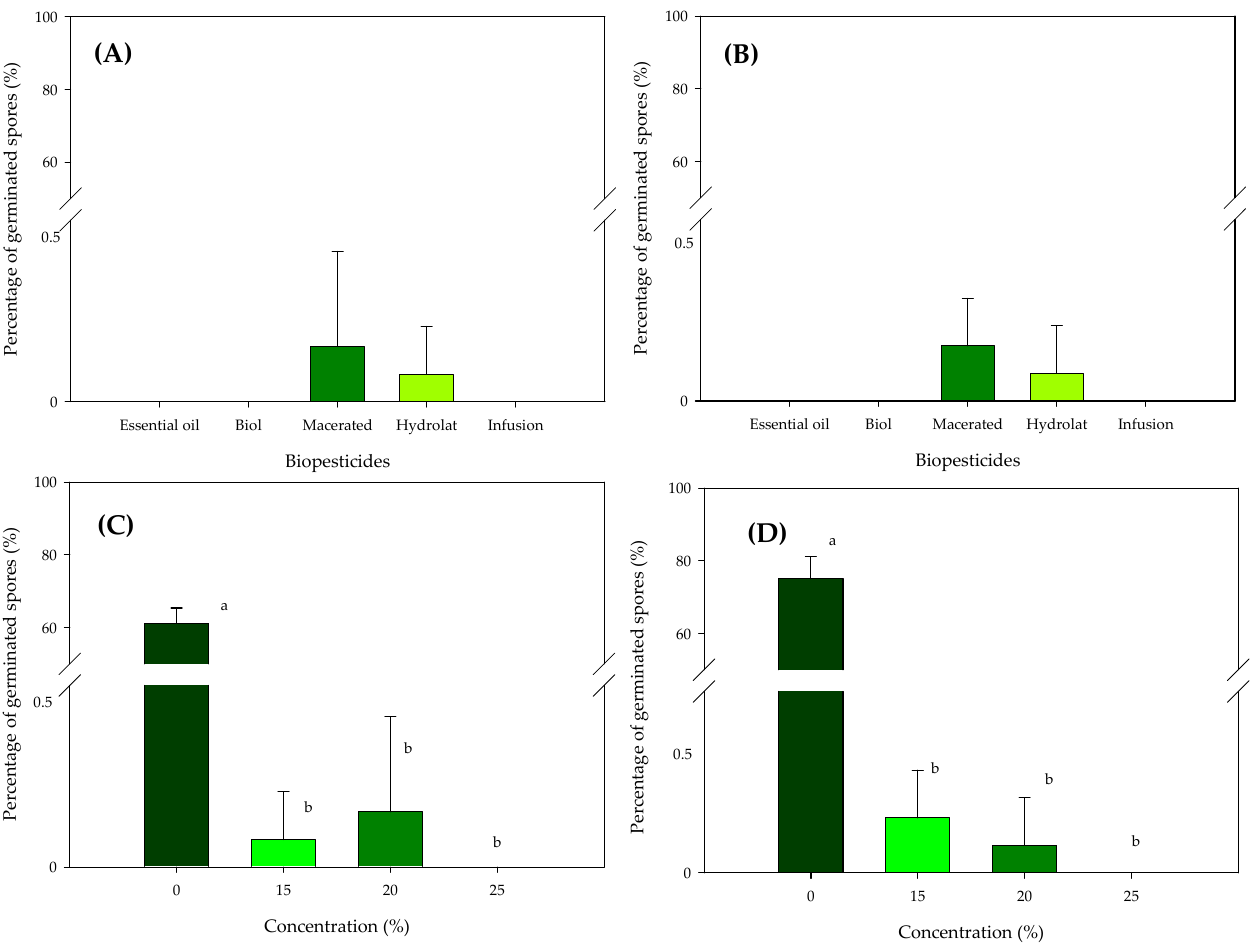
Figure 2. Comparison of means in relation to the percentage germination of rust uredospores in five biopesticides ( A , B ), applied at four concentrations ( C , D ) and evaluated under light ( A , C ) and dark ( B , D ) conditions in laboratory conditions. Different lowercase letters in the bars represent significant differences using Tukey’s test at 5% probability.